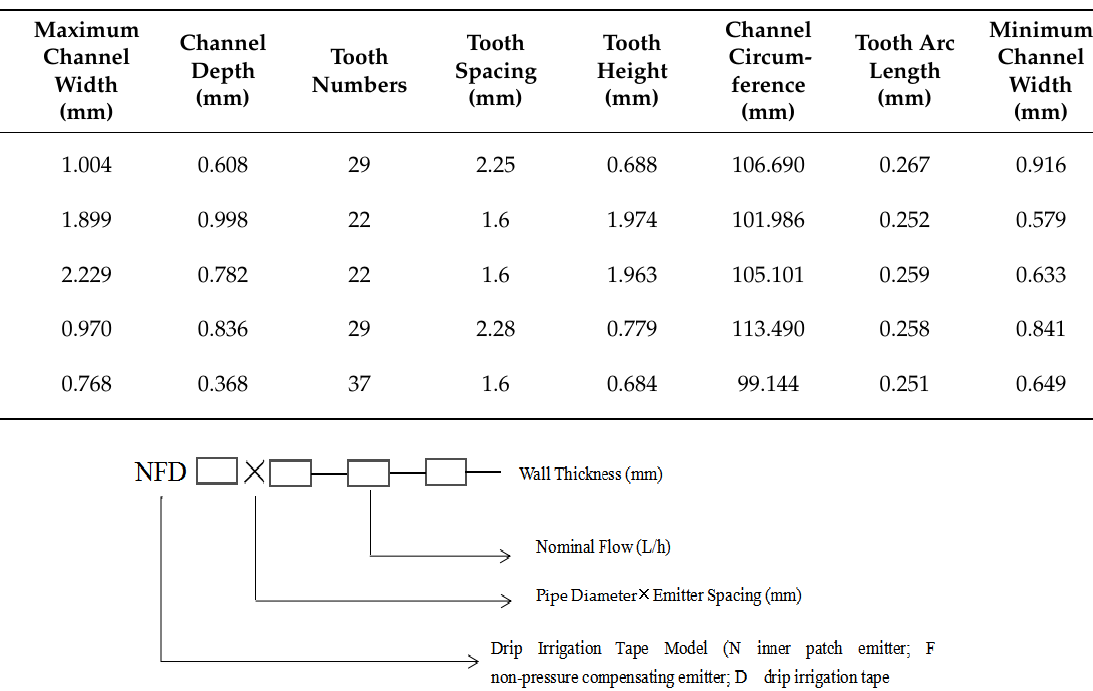
Figure 1. Schematic diagram of the drip irrigation tape model number.